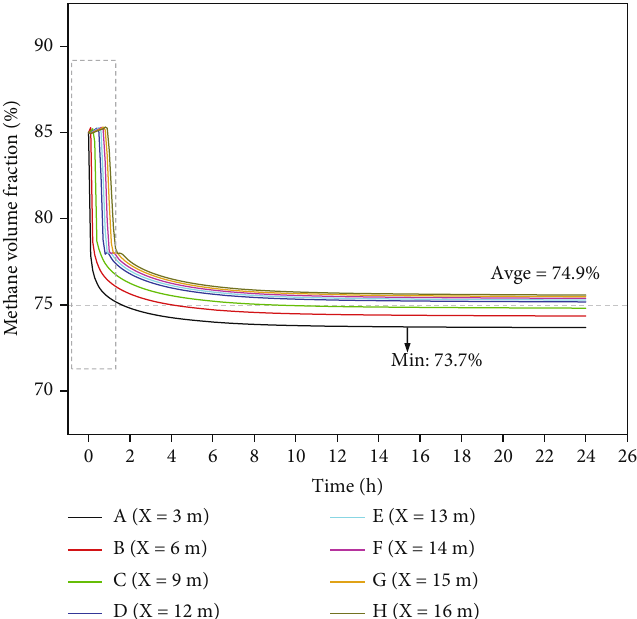
Figure 7: Time-dependent V